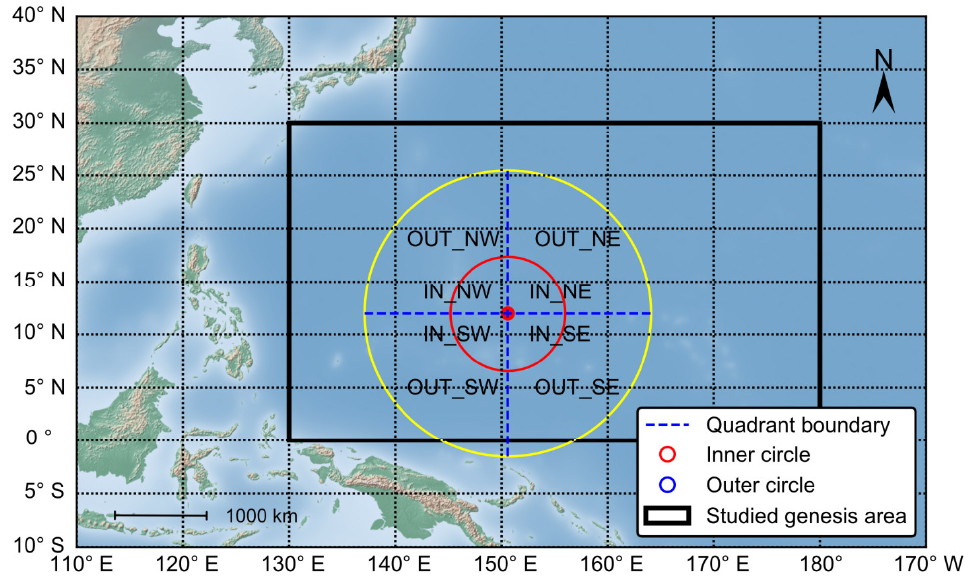
Figure 1. Illustration of studied genesis area (black rectangle) and eight storm-centered sectors where variables are averaged. Red point is location of TC center, dashed blue lines are boundaries of four quadrants, and red and yellow circles represent radii of 600 km (inner circulation) and 1500 km (outer environment), respectively.